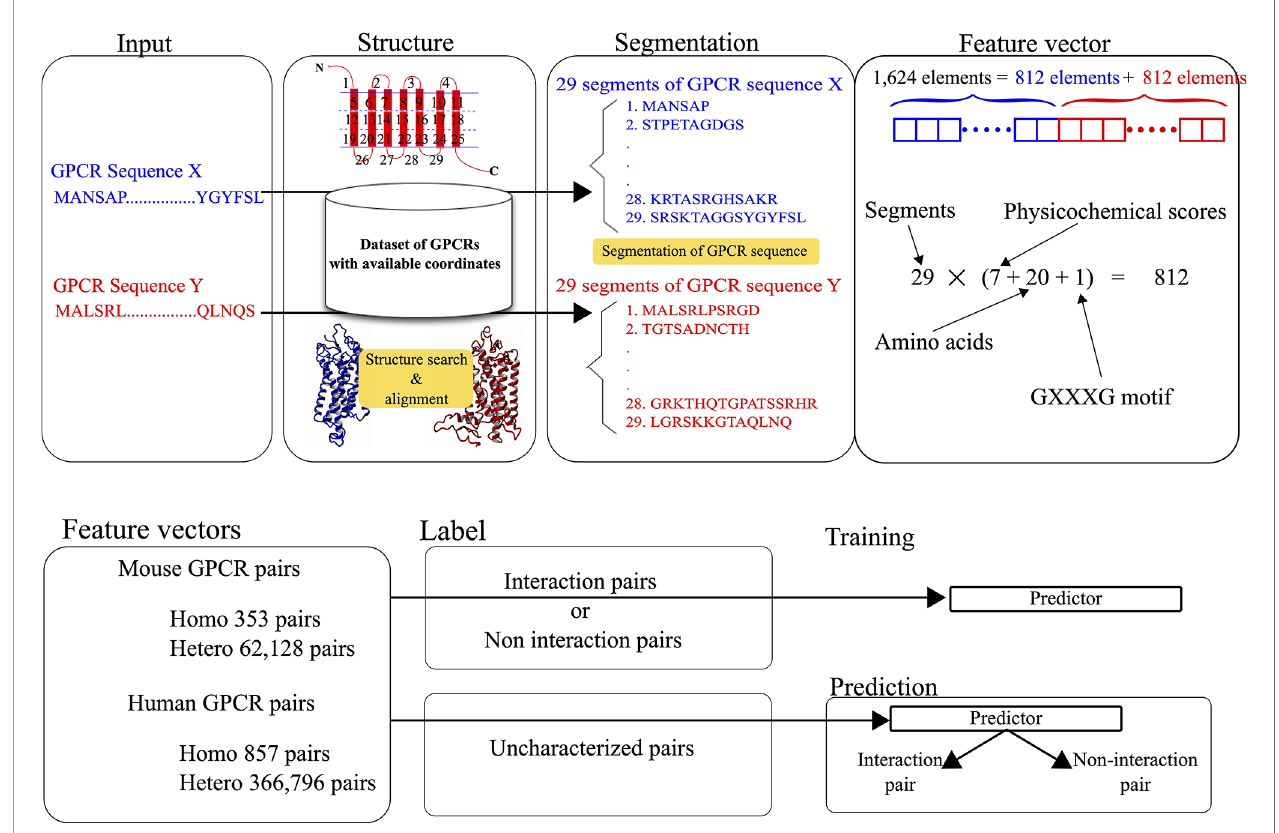
FIGURE 1 | Data processing for the development and prediction of